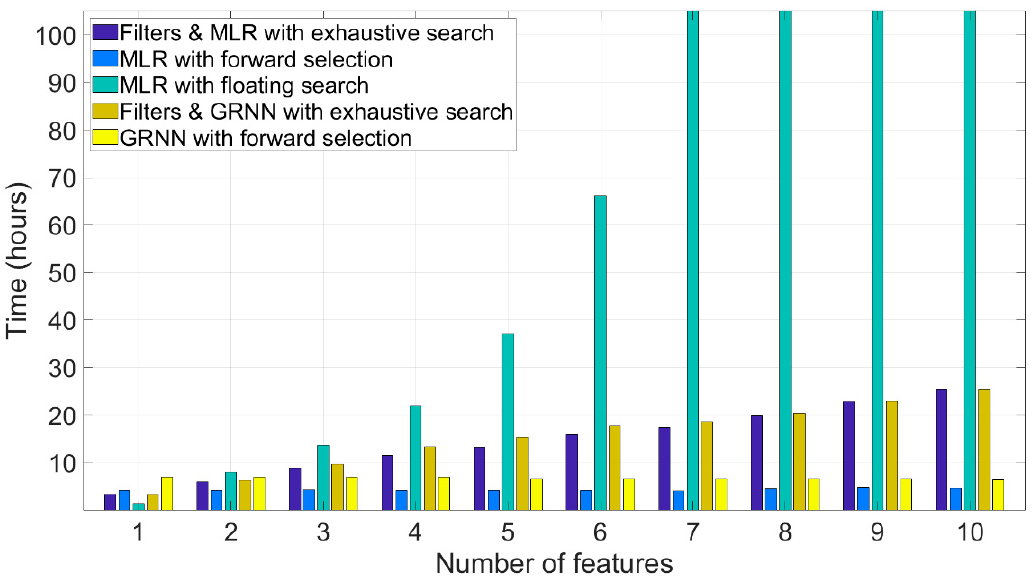
Figure 10. Computation times in feature selection. Computation times above 105 h are omitted for